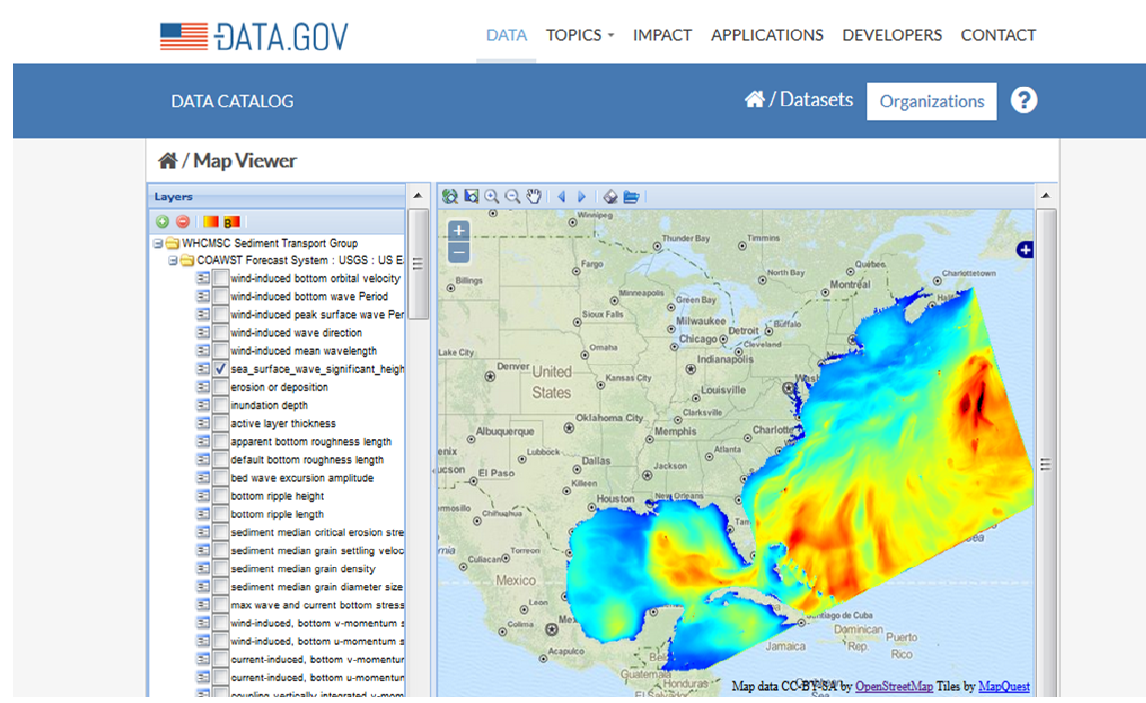
Figure 10. Viewing a discovered USGS CMG data set in the Data.gov built-in Map Viewer application. The Map Viewer is requesting this image from the WMS service built into the THREDDS Data